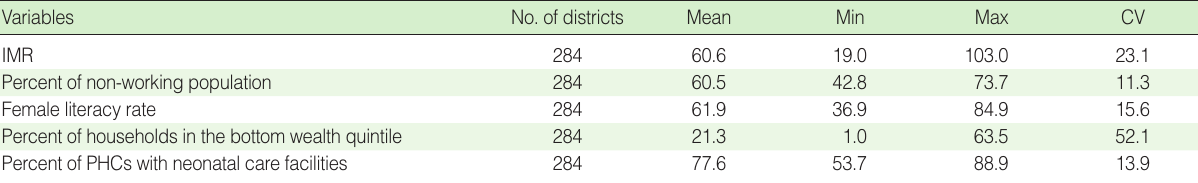
Table 1. Descriptive statistics of the IMR and its explanatory variables